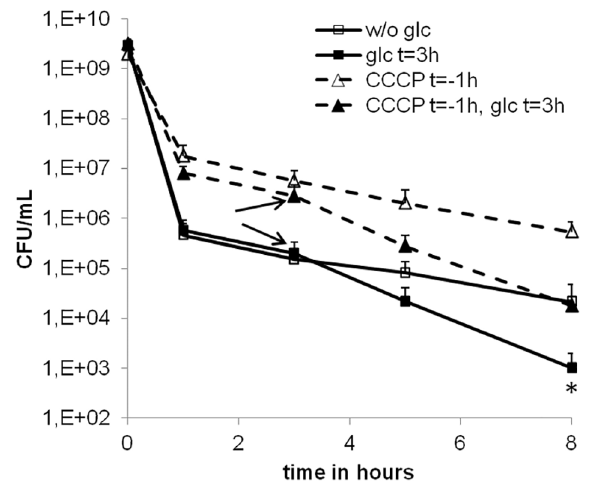
Fig 3. Influence of the proton motive force. CCCP pretreatment of DAP challenged SA113 cultures. Stationary phase SA113 cells were treated with 50 μ M CCCP (triangles) at t = -1h, corresponding to one hour before the addition of 100-fold the MIC of DAP. At t = 3h (arrows), glucose was added to cultures (filled symbols). Cultures without CCCP pretreatment (squares) were handled identically. For statistical analysis endpoint ODs after eight hours were compared by 1-way ANOVA with Bonferroni's Multiple Comparison Test. * p < 0.05.